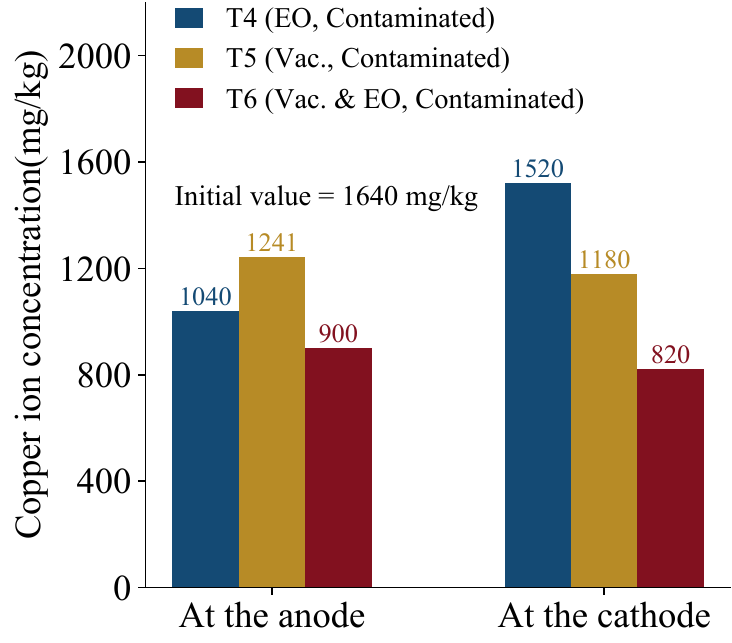
Figure 9. Copper ion concentration at the anode and the cathode after the